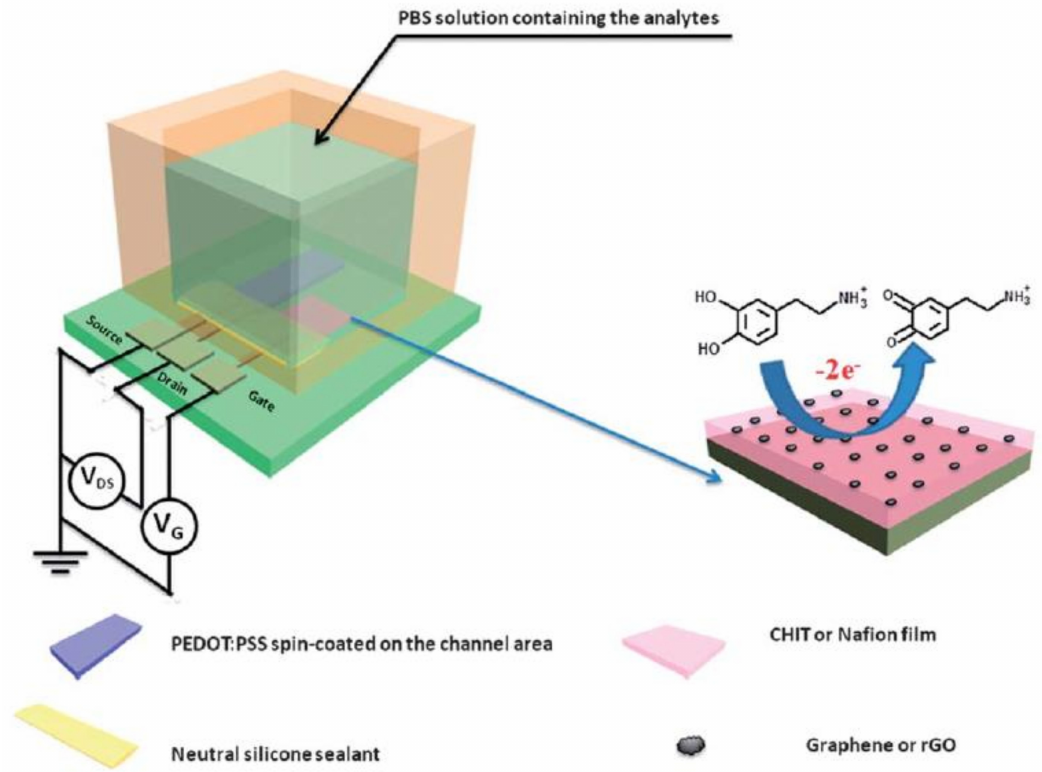
Figure 14. Architecture of the OECT-based dopamine sensor, with electrolyte, gate ad PEDOT:PSS channel ( left ). Detail of the gate structure, with Nafion (or chitosan) and graphene (rGO) flakes immobilized on a Pt electrode. The electro-oxidation of dopamine occurs on the surface of the gate ( right ). Reproduced with permission from [100]. © Materials Research Society